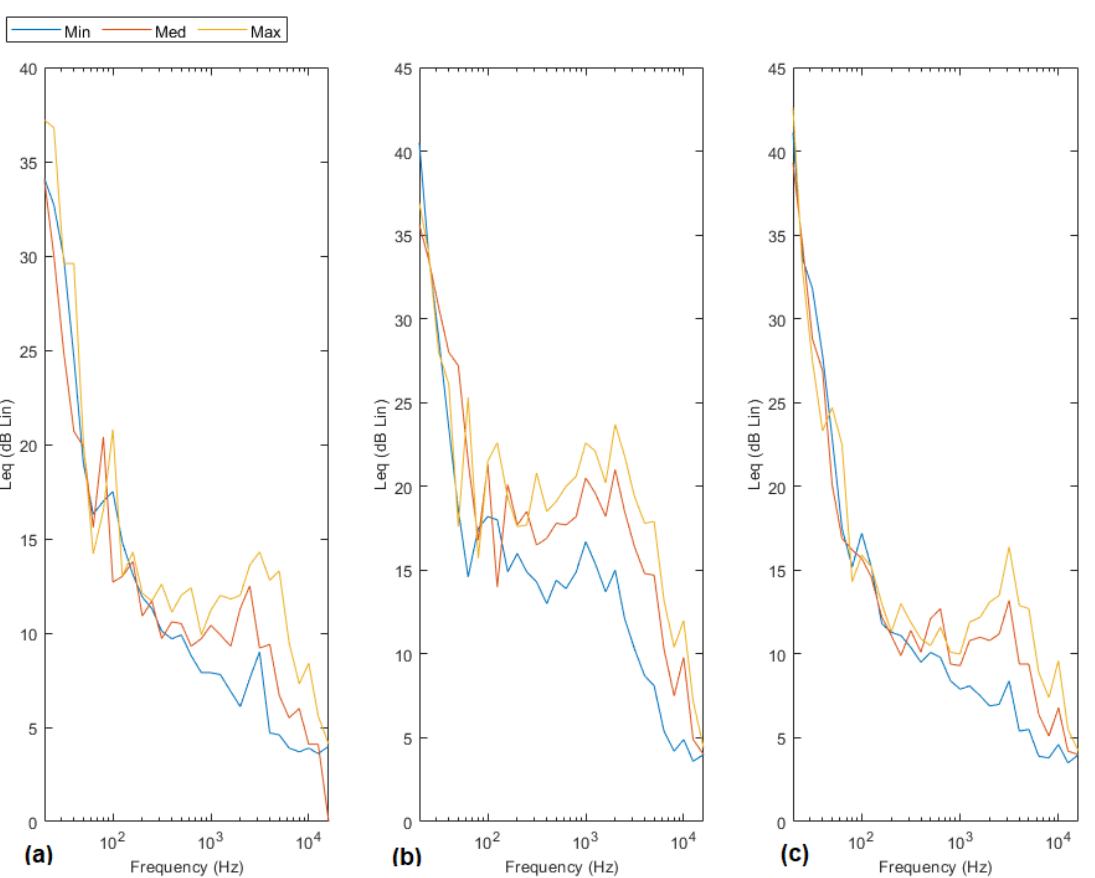
Figure 6. Spectral levels in a range spanning a third of an octave, 20 Hz to 16 kHz, for the three operating scenarios used in the measurement session at the three microphone placements (dB Lin). (( a ): 180°, ( b ): 270°, ( c ): 360°).